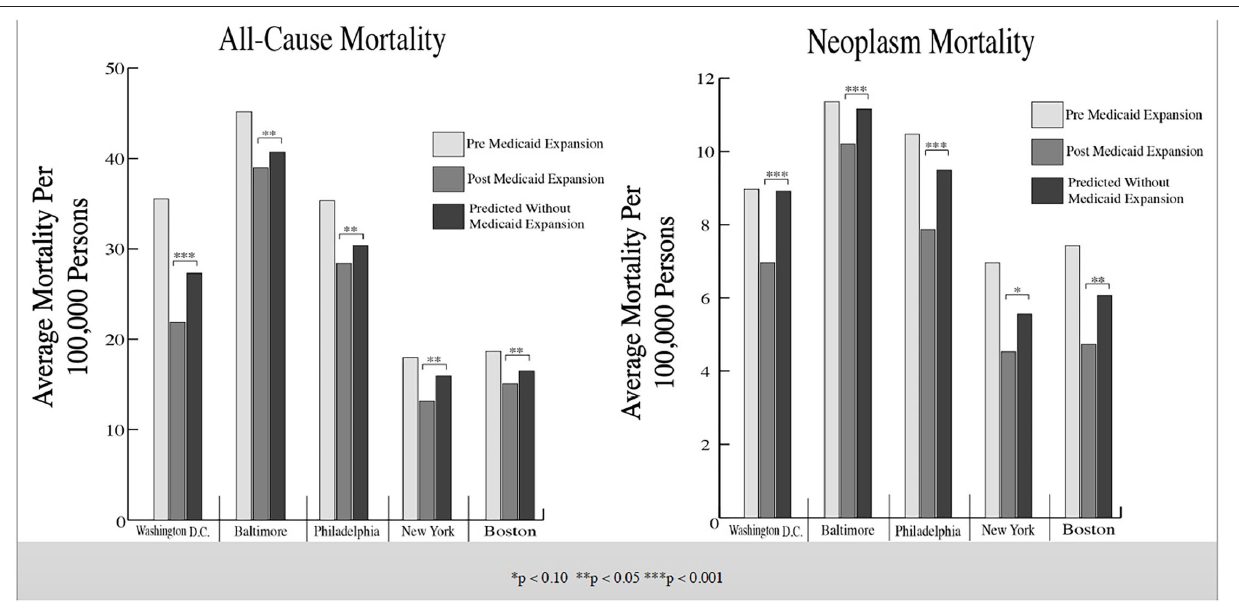
FIGURE 11 | Average mortality rates among treated cities and synthetic control cities. These bar graphs represent the average mortality rate of the selected Northeastern cities. Mortality rates before and after Medicaid expansion are illustrated along with the predicted average mortality rates if Medicaid expansion had not occurred in said cities (derived by the generalized synthetic control